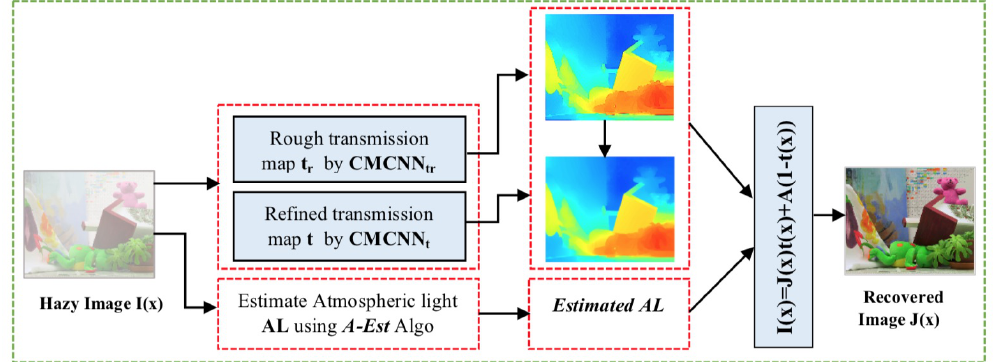
Figure 2. Diagram of the proposed dehazing